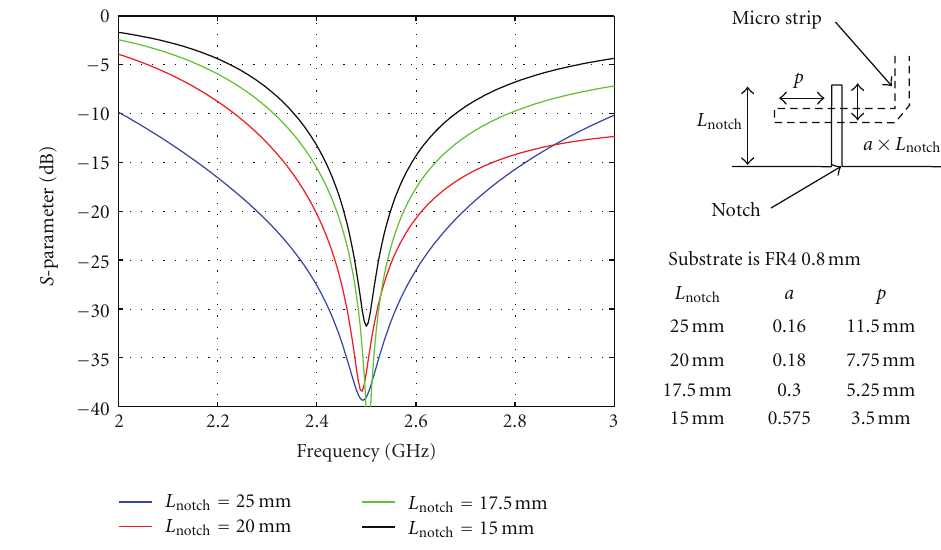
Figure 2: Impedance matching of notch with reduced